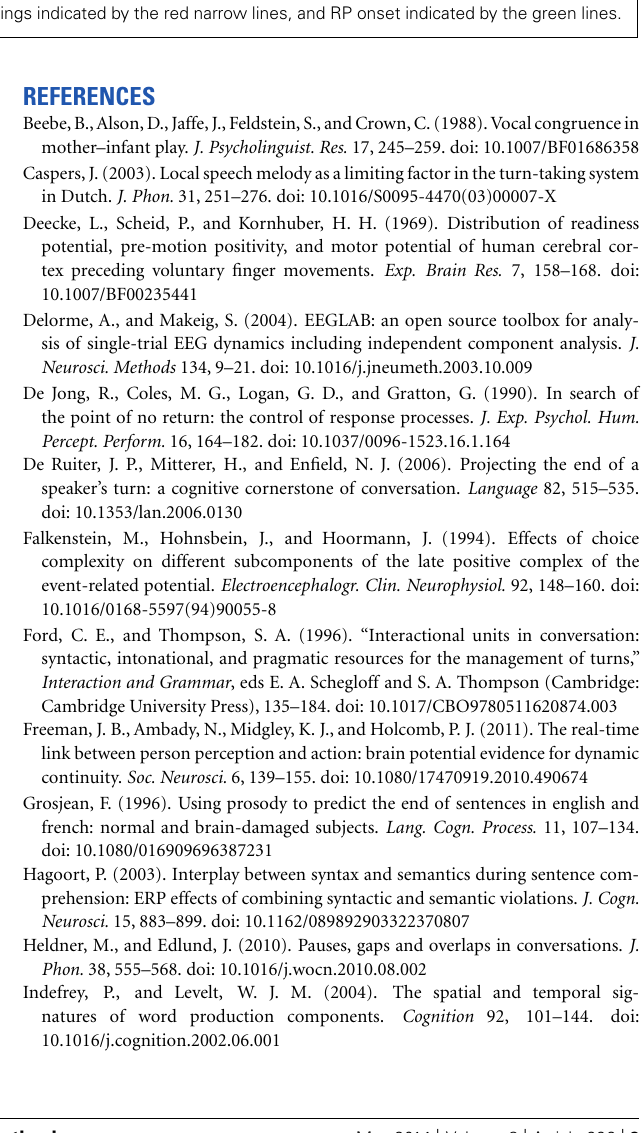
FIGURE 5 | Illustration of schematic temporal sequences of the sentence-internal violation, RP onset and the response after sentence ending. Time-locked to the sentence end at the blue vertical line, with the violation-endings indicated by the red narrow lines, and RP onset indicated by the green